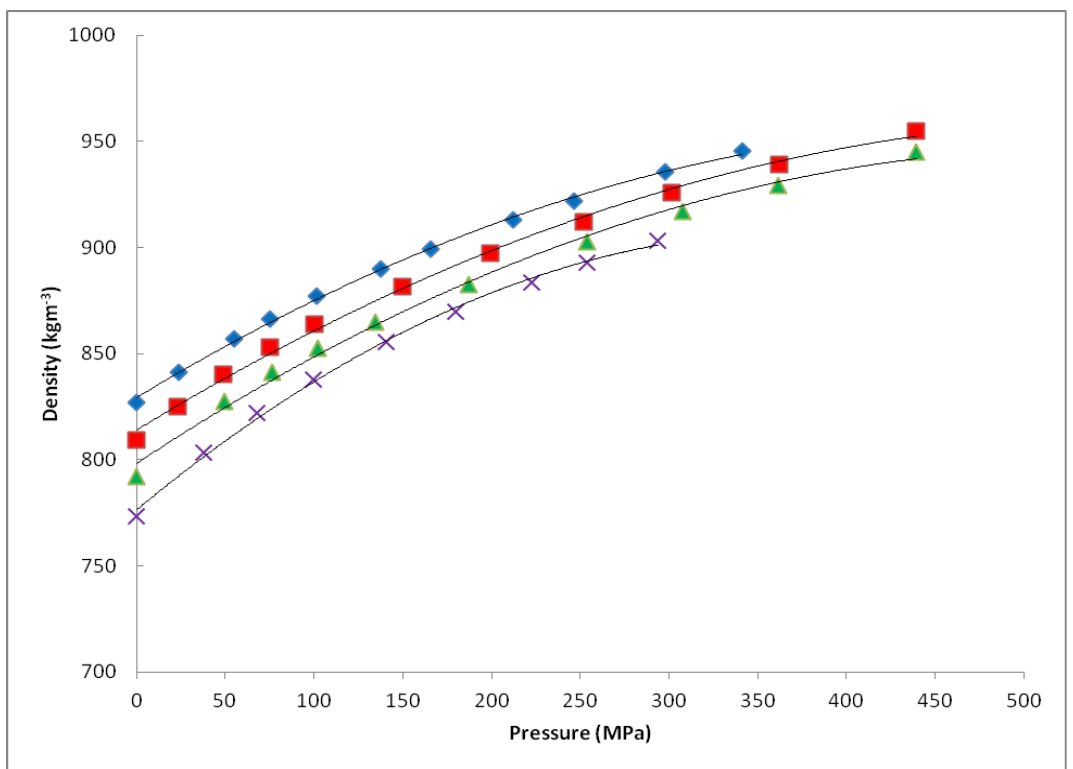
Figure 5. Variation of density for Fuel 2 with temperature. ♦ 298 K, ■ 323 K, ▲ 348 K, and X 373